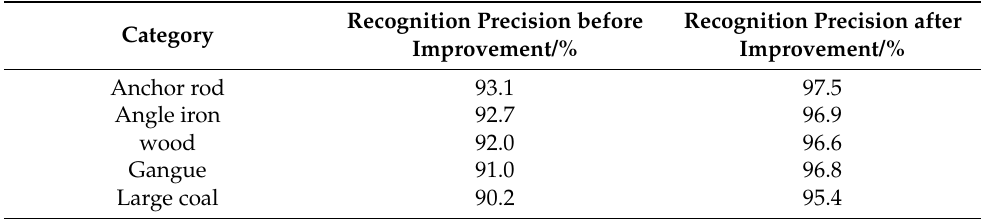
Table 3. Comparison of foreign objects recognition precision before and after improvement.